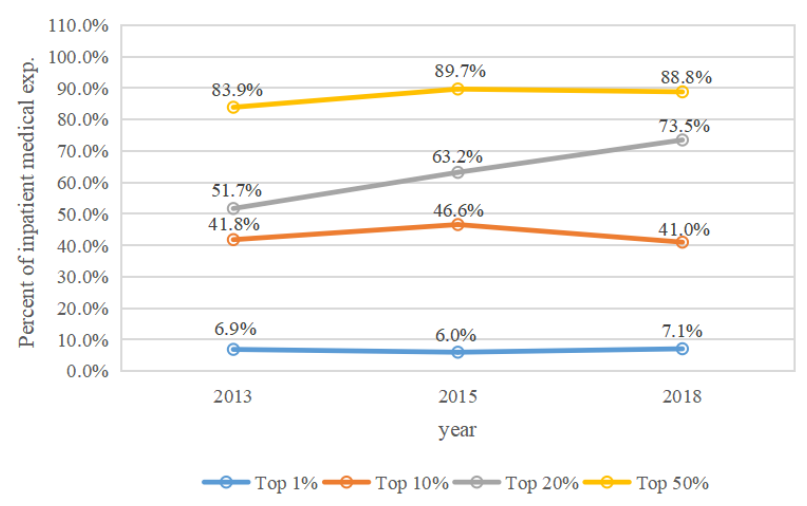
Figure 2. The concentration of inpatient medical expenses by year.